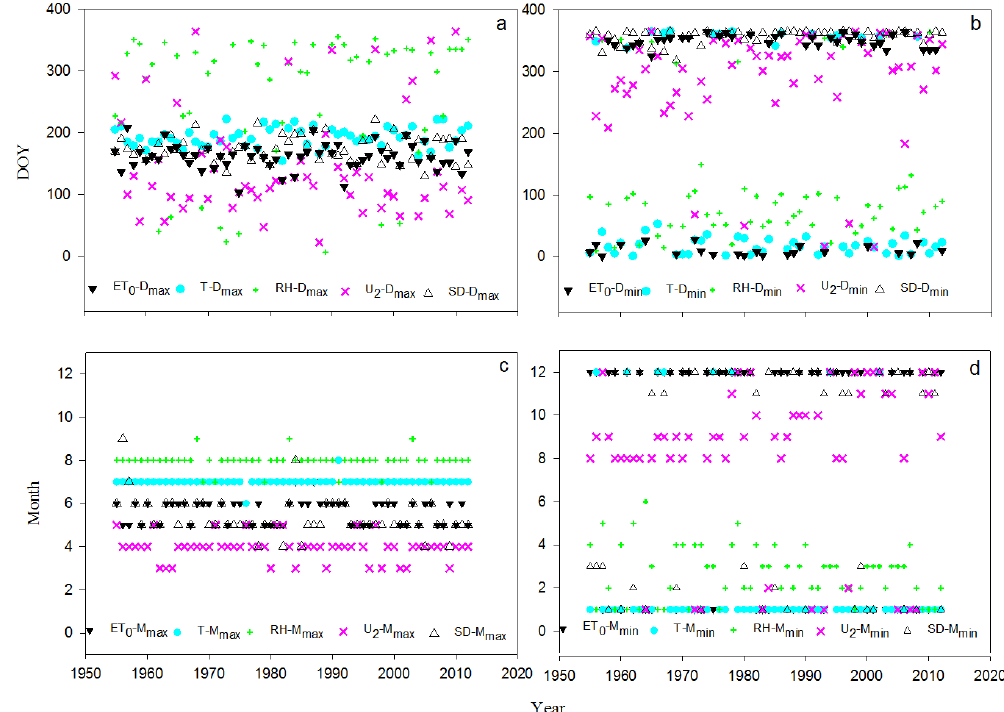
Figure 4. The occurrence of the maximum (left panels) and the minimum (right panels) of ET 0 and meteorological variables at daily (upper panels) and monthly (lower panels)